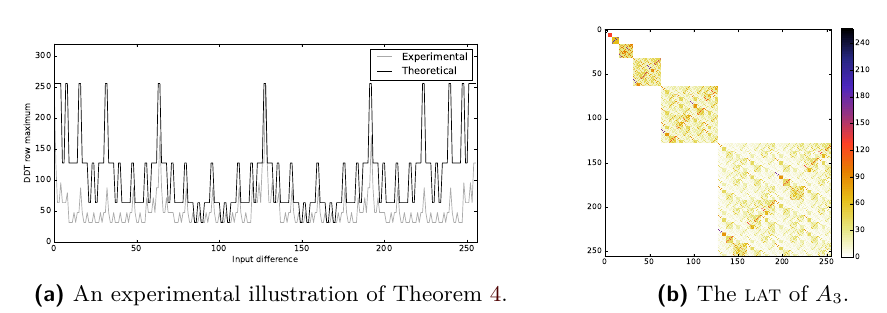
Figure 7: Some properties of A 3 for n = 8. Figure (a) is a visual representation of the LAT[ a ][ b ] of A , where the x axis corresponds to a and the y axis corresponds to b . 3